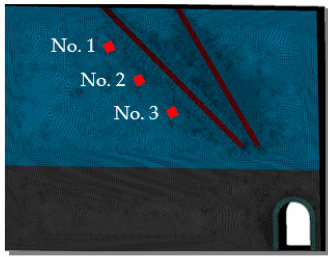
Figure 1. Three-dimensional numerical model of the deep-hole blasting used in this analysis.